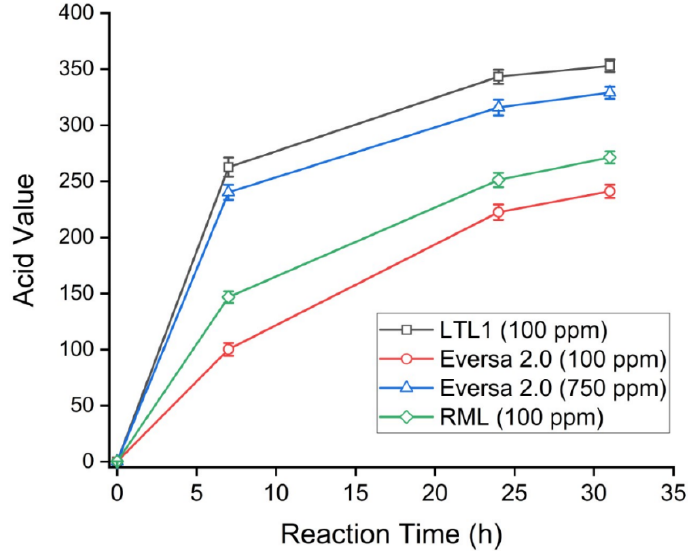
Figure 5. Time-course hydrolysis of C8-C10 ME by LTL1, RML, and Eversa 2.0. Enzyme dosage is 100 or 750 ppm (w/w based on oil weight). The reaction was conducted as follows: 20 g of C8-C10 ME, 40 mL of water, 100 to 750 ppm of lipases, 45 °C, under 55 mbar vacuum.